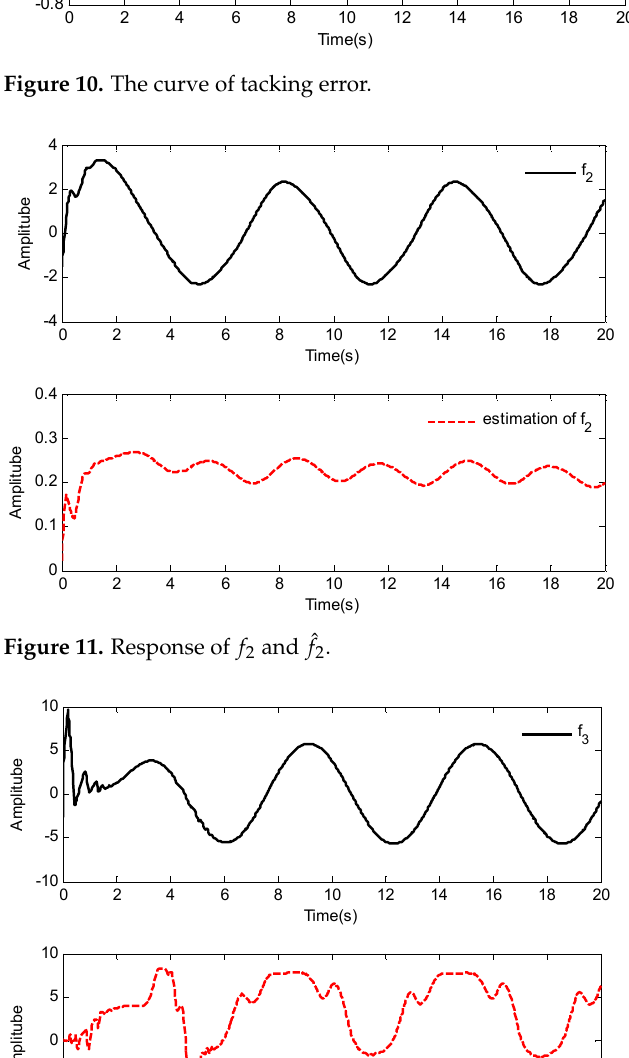
Figure 12. Response of f 3 and ˆ f 3